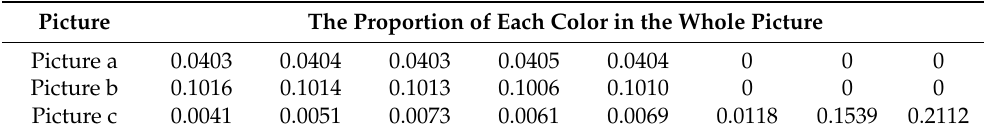
Table 2. The verification results of different pictures.